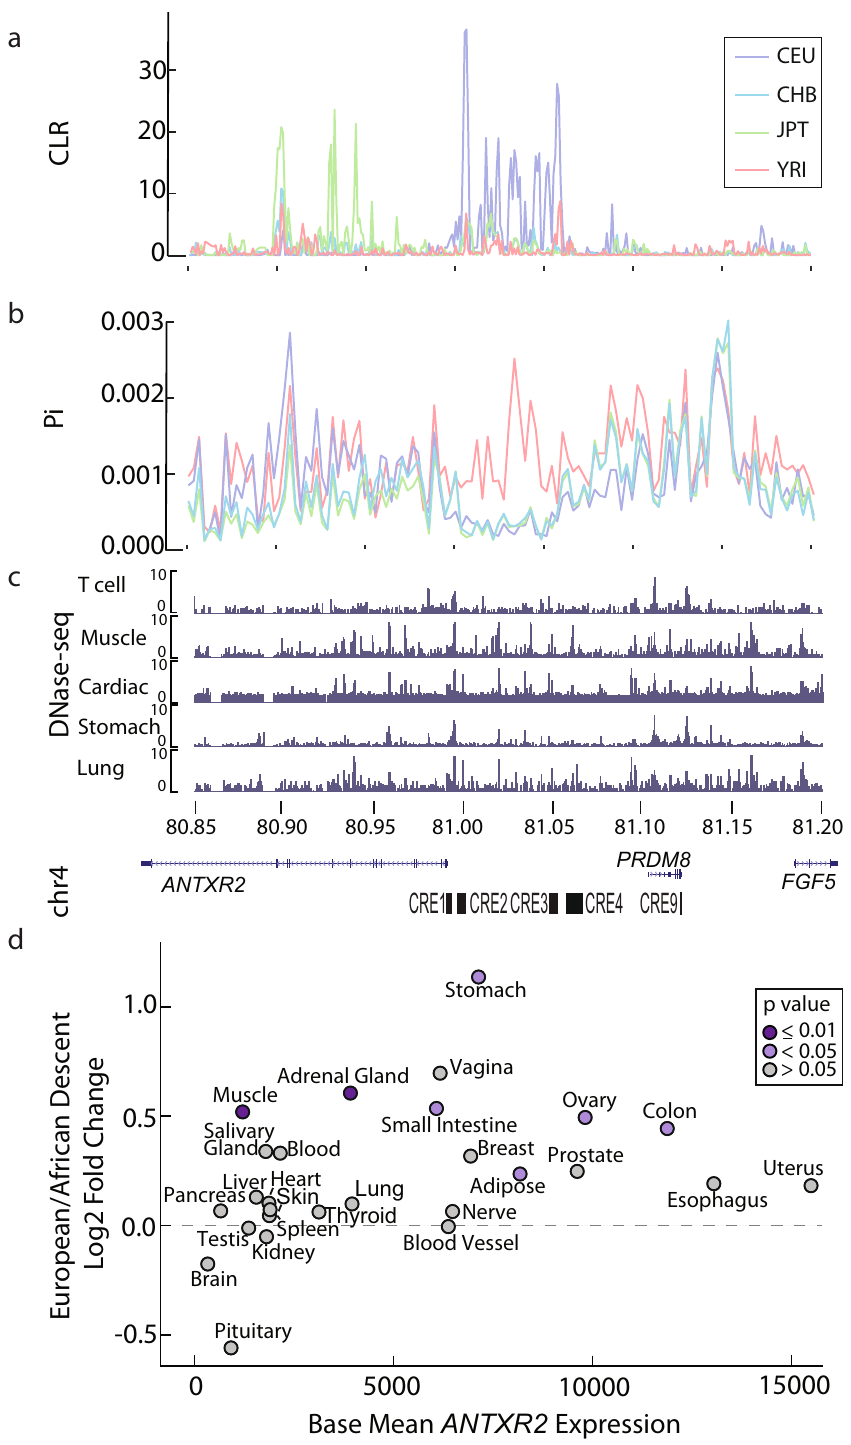
Fig. 3 Selective sweep affects ANTXR2 expression in multiple tissues. a Sweep fi nder2 CLR (composite-likelihood-ratio) values for CEU (Northern and Western Europe), CHB (China), JPT (Japan), and YRI (Yoruba) populations show a predicted selective sweep in the CEU population upstream of ANTXR2 at 81 – 81.05 Mb. b Pi diversity values for CEU, CHB, JPT, and YRI populations show decreased diversity in the predicted selective sweep in CEU, CHB, and JPT (see Supplementary Fig. 17 for percentiles). c ENCODE DNase-I-seq data for T cells, muscle, heart, stomach, and lung show different numbers and locations of DNase-I hypersensitive sites, which indicates differential regulatory landscapes in cell types within the predicted selective sweep in CEU. d Differential expression of GTEx data for all available tissues showed a range of fold changes of individuals of European descent compared to individuals of African descent (as determined by mitochondrial haplotype). The majority of tissues showed greater expression in individuals of African descent ( n = 22/27). Source data are provided as a Source Data fi